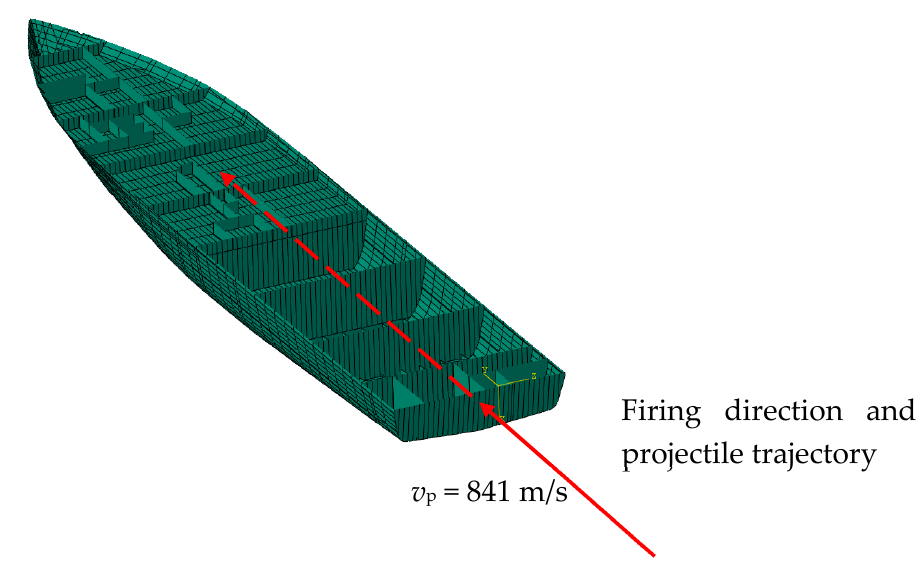
Figure 7. Ship’s interior with the expected projectile trajectory.